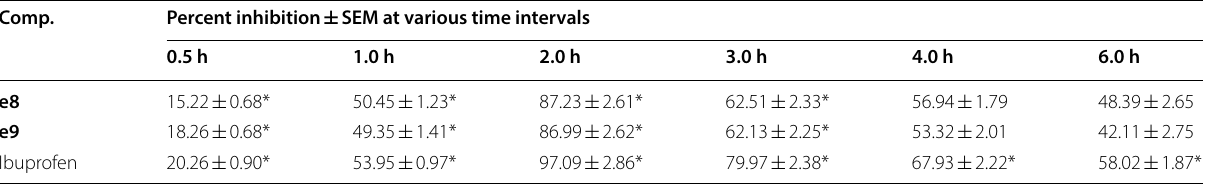
All values are represented as mean compounds-10 mg/kg body weight by orally